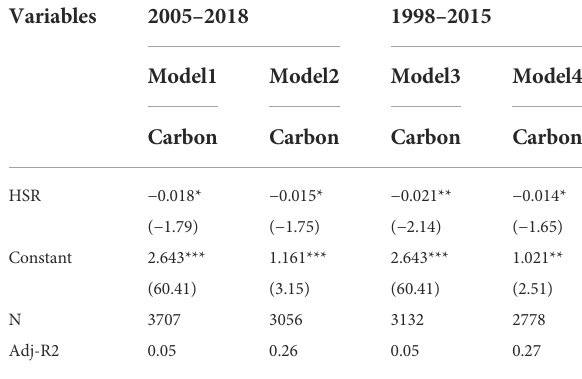
TABLE 9 Robustness check: Various